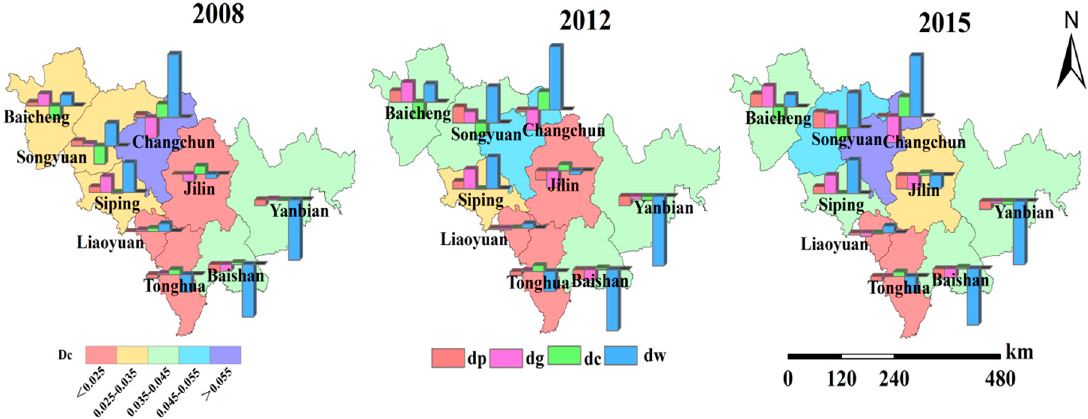
Figure 7. Spatial variation of WF inequity in Jilin Province.